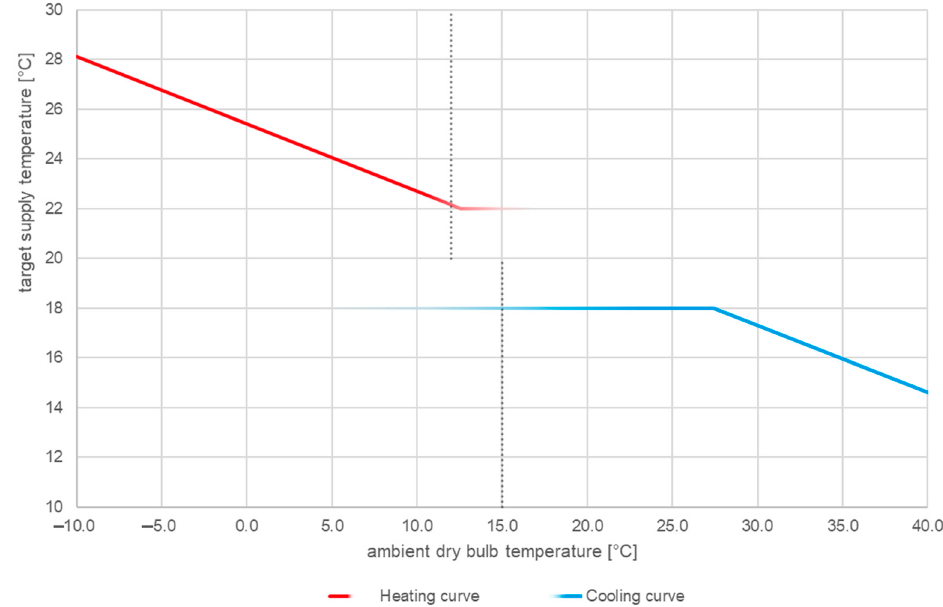
Figure 4. Exemplary heating and cooling curve for TABS (own